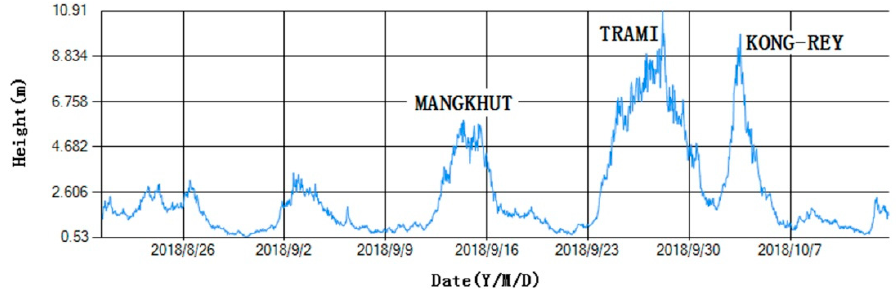
Figure 19. Data curve of significant wave heights from the SBF7-1A GPS wave buoy during three typhoons. Table 3. Maximums of significant wave height from the SBF7-1A GPS wave buoy in three typhoons. Typhoon